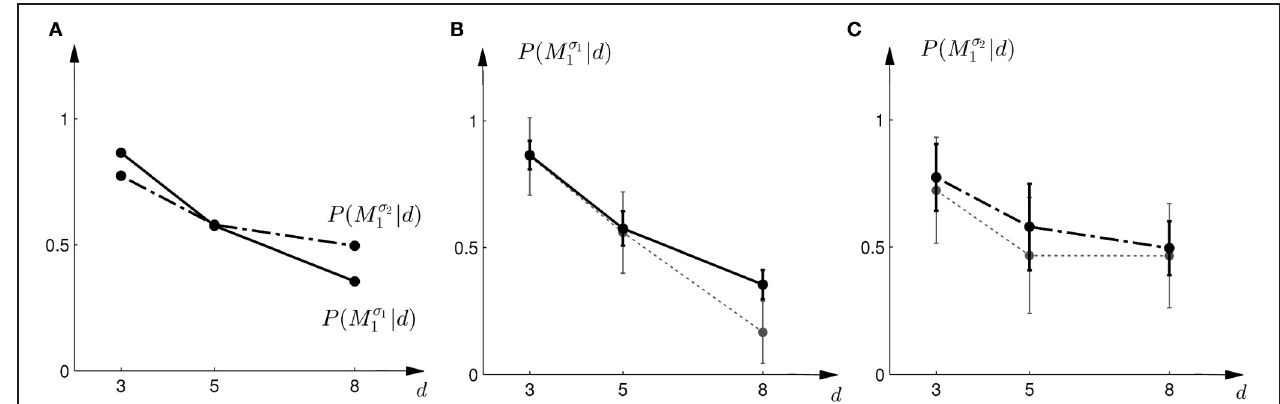
subjects. The corresponding standard deviation error bars are shown in panels (B,C) . (B) Shows the predictions for the first part of the study (solid line) and the experimental results for three different widths d of the ambiguous feedback array. The dotted line shows the mean and standard deviation across subjects of the experimentally observed probabilities of choosing M σ 1 1 . (C) Shows the predictions (dash-dot line) as well as the experimentally observed choice probabilities (dotted line) for choosing M σ 2 1 in the second part of the